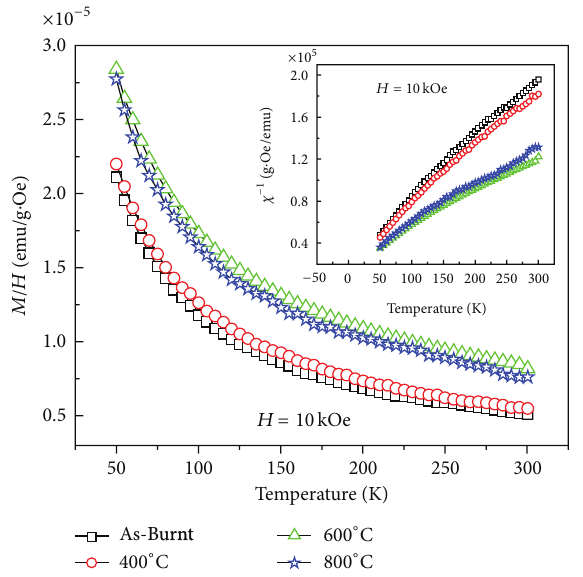
Figure 5: Temperature-dependent 𝑀/𝐻 and (inset) inverse mag- netic susceptibility ( 𝜒 −1 ) of as-burnt and annealed Zn 0.95 Mn 0.05 O.